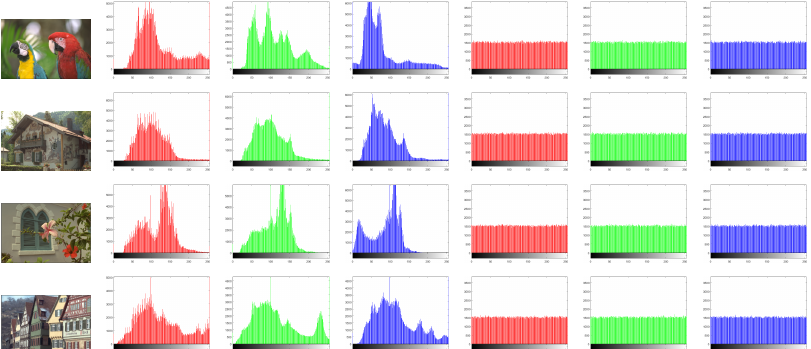
Figure 15. Plots of histograms for experimented images, in which the left three columns except the first one represent the histograms of plain images, while the right three columns represent the histograms of cipher images. Table 5. χ 2 outcomes for the investigated images.